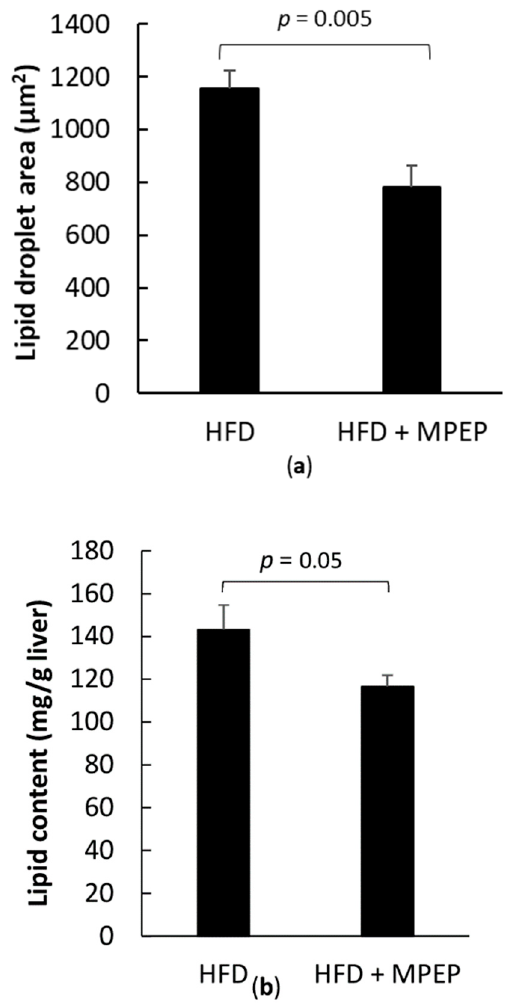
Figure 2. Lipid droplet area and total lipid content in obese mice. ( a ) Lipid droplet area was measured on H & E stained liver sections using ImageJ; ( b ) Total lipid content was obtained by fluorimetric measurements of Nile Red levels in lipid extracts. HFD: high-fat diet + vehicle group; HFD + MPEP: high-fat diet + 20 mg/Kg MPEP group. Results are mean ± SE of 6 individual determinations.